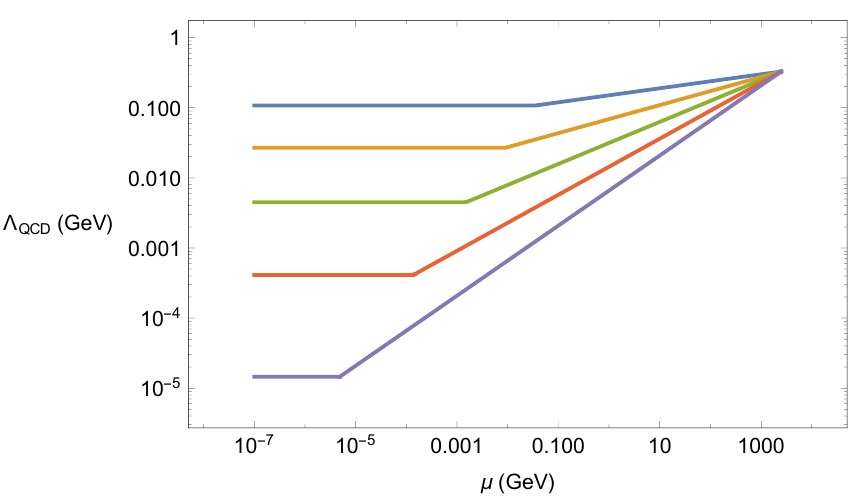
Figure 1 . Schematic plot of the QCD con(cid:12)nement scale (cid:3) QCD as a function of the IR scale (cid:22) for (cid:22) min = 2 : 5 TeV, n c = 3 and n = 0 : 1 ; 0 : 2 ; 0 : 3 ; 0 : 4 ; 0 : 5 (in blue, yellow, green, red,